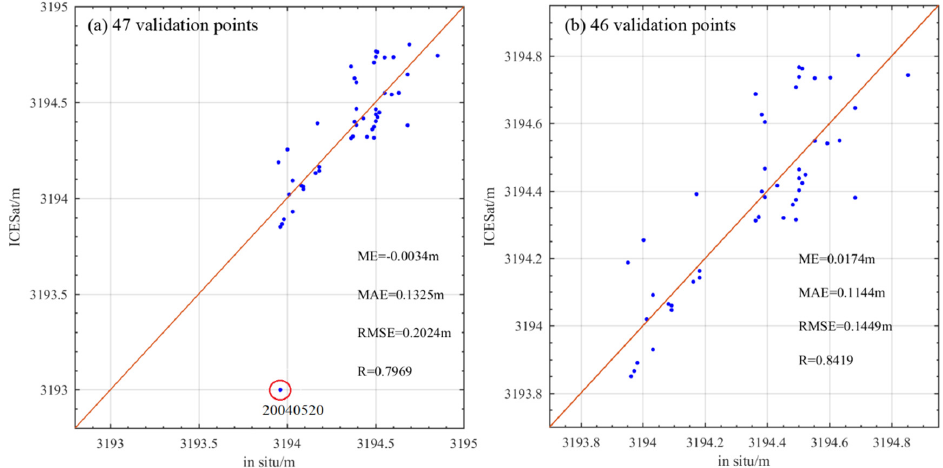
Figure 8. The validation results of the ICESat using the in-situ water level: ( a ) the total validation points, red circle represents abnormally deviated scattered point; ( b ) 46 validation points with one point excluded).